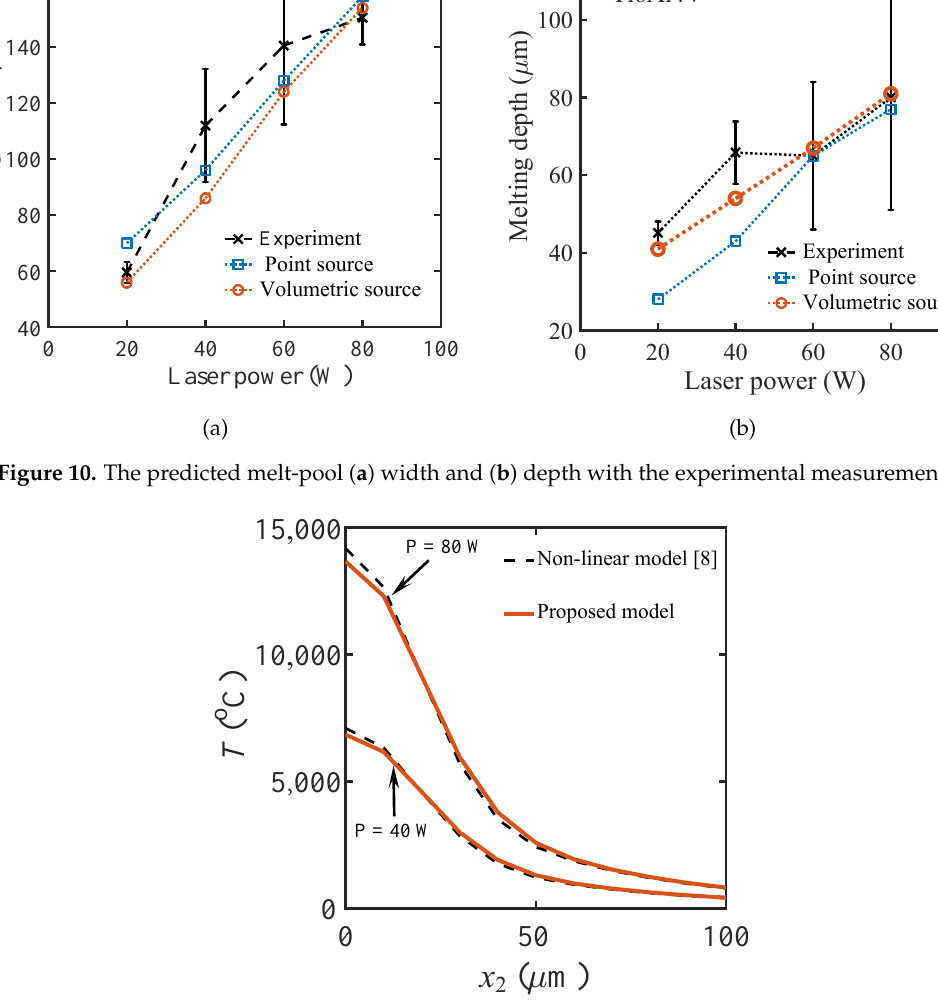
Figure 11. The temperature along the width direction (see line 1 in Figure 9) obtained by the proposed volumetric heat source model and the nonlinear model reported in